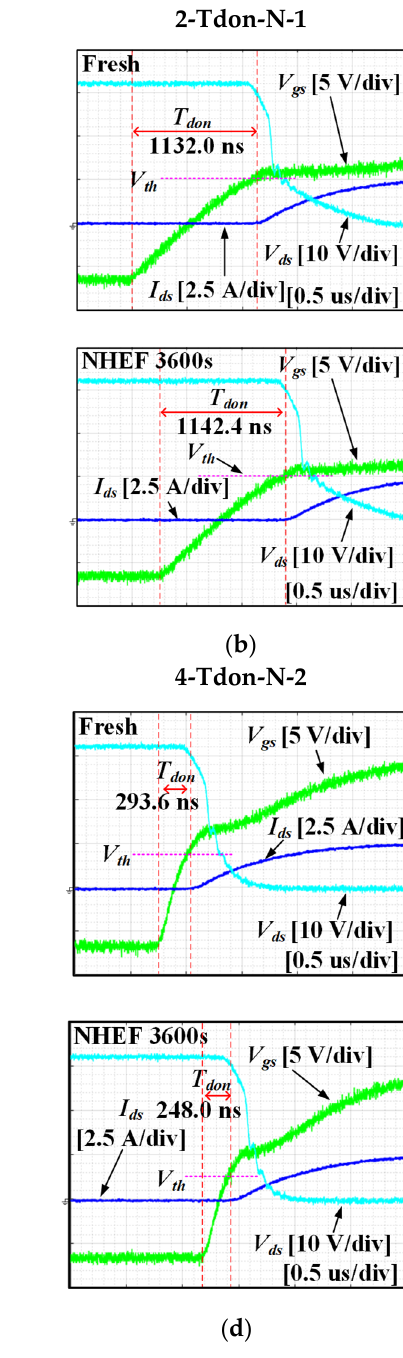
Figure 14. Turn on waveforms in NHEF stress: ( a ) 1-Tdon-P-1, ( b ) 2-Tdon-P-2, ( c ) 3-Tdon-P-1, and ( d ) 4-Tdon-P-4.